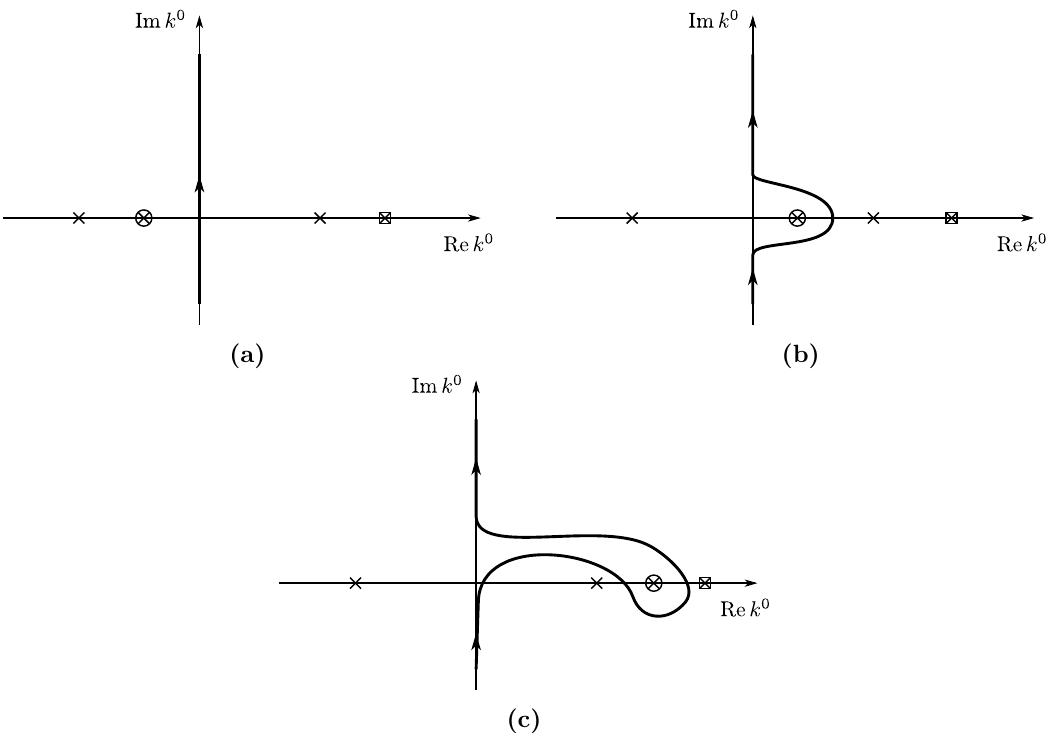
Figure 7. Integration contour after analytic continuation to external Lorentzian momenta. De- pending on the values of the external momenta, di(cid:11)erent cases can